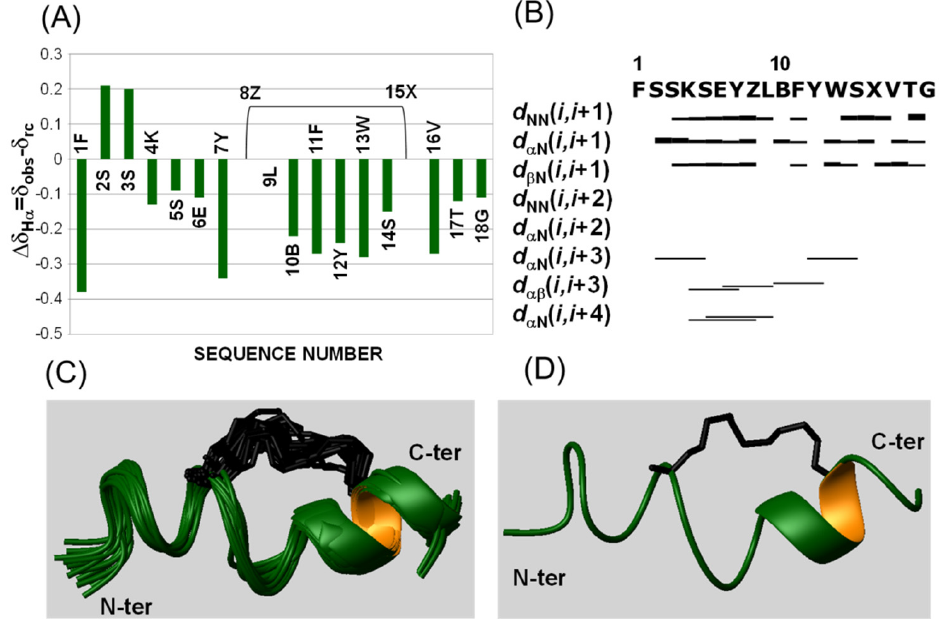
Figure 3. NMR analysis of KIRCONG i/i+7 in H 2 O/TFE 60/40 v / v . ( A ) Chemical shift deviations of H α protons from random coil values ( ∆δ H α ). Standard amino acids are reported with the one letter code whereas, B stands for β -Alanine, Z stands for (R)-N-2-(7 ′ -octenyl) alanine and X stands for (S)-2-(4 ′ -pentenyl) alanine. ∆δ H α for Z and X is set equal to 0 as the reference random coil value is missing. For ∆δ H α evaluation β -Alanine was assimilated to Glycine. ( B ) NOEs pattern. ( C ) Ribbon representation of KIRCONG i/i+7 NMR structures: 20 conformers are superimposed on the backbone atoms of residues 3–17, and ( D ) ribbon representation of the first NMR conformer. The aliphatic linker between (R)-N-2-(7 ′ -octenyl) alanine (residue n.8) and (S)-2-(4 ′ -pentenyl) alanine (residue n.15) is shown in black. The NMR structure was generated from 261 upper distance limits (170 intraresidue, 58 short-range, 27 medium-range and 6 long-range) and 73 angular constraints.